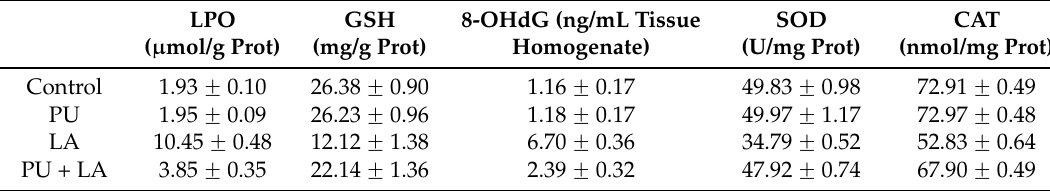
Table 1. Effect of punicalagin (PU) on lipid peroxidation (LPO), glutathione GSH, 8-hydroxy-2’- deoxyguanosine (8-OHdG), superoxide dismutase (SOD) and catalase (CAT) in lead acetate (LA)- intoxicated mice testis (mean ˘ standard deviation